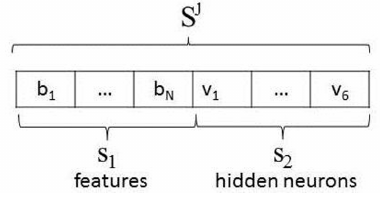
Figure 7. Individual